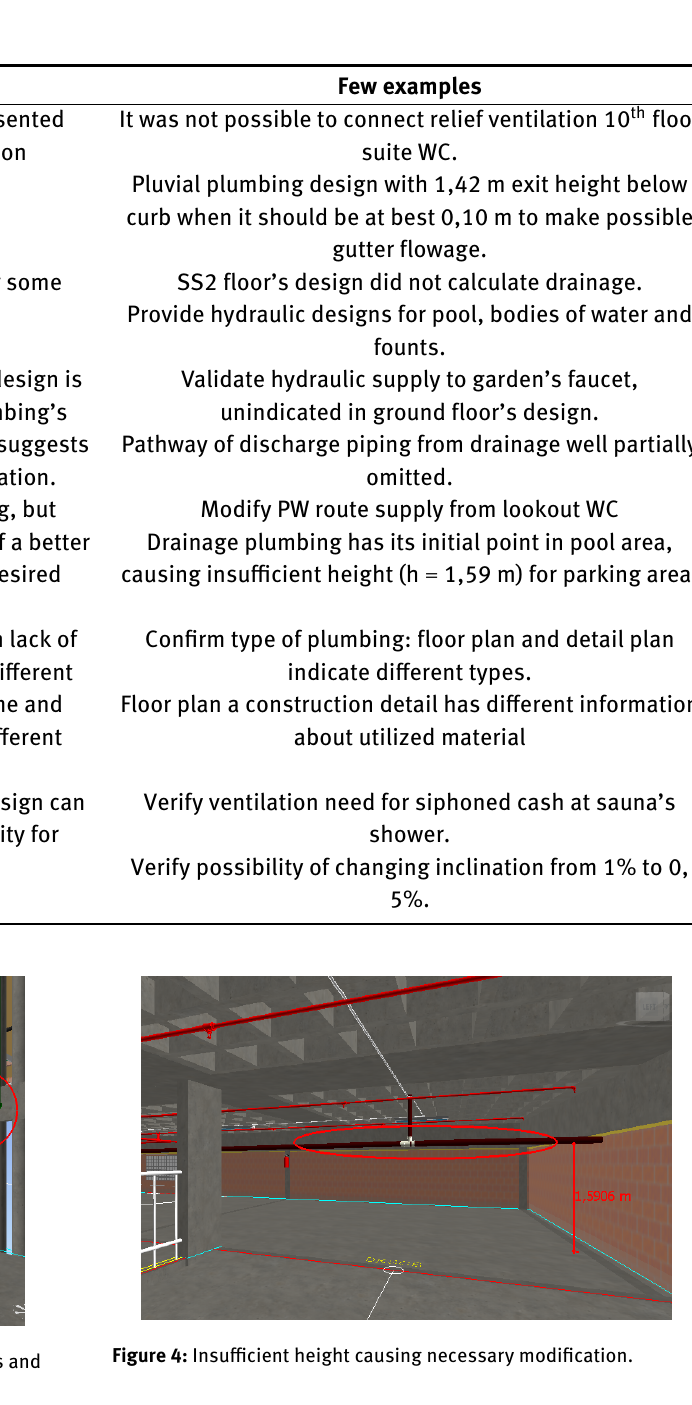
tion between them using a “Y” connector. Minimal dis- tance verified by virtual construction in order to support execution was 330 mm between 100 mm plumbing axes. Figure 3 demonstrates divergence of information where highlighted plumbing has a different specification on floor plan drawings and isometric detail.